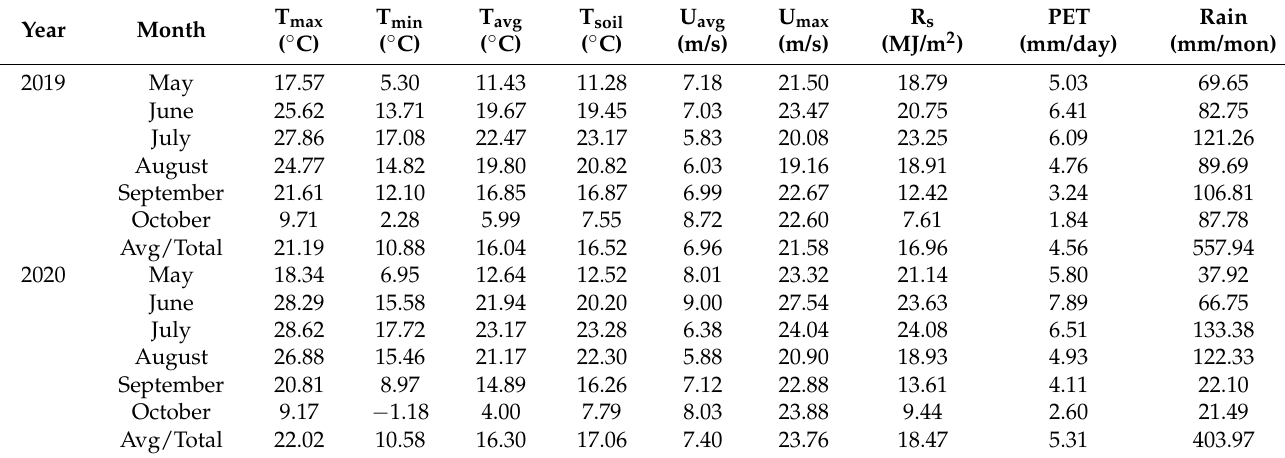
Table 4. Major weather parameters (Tmax, monthly average maximal air temperature; Tmin, monthly average minimal air temperature; Tavg, monthly average air temperature; Tsoil, monthly average bare soil temperature at 10 cm depth; Uavg, monthly average wind speed; Umax, monthly average maximum wind speed; Rs, monthly average incoming shortwave radiation; PET, monthly average total daily potential evapotranspiration amount; and Rain, monthly average total rainfall) during the field